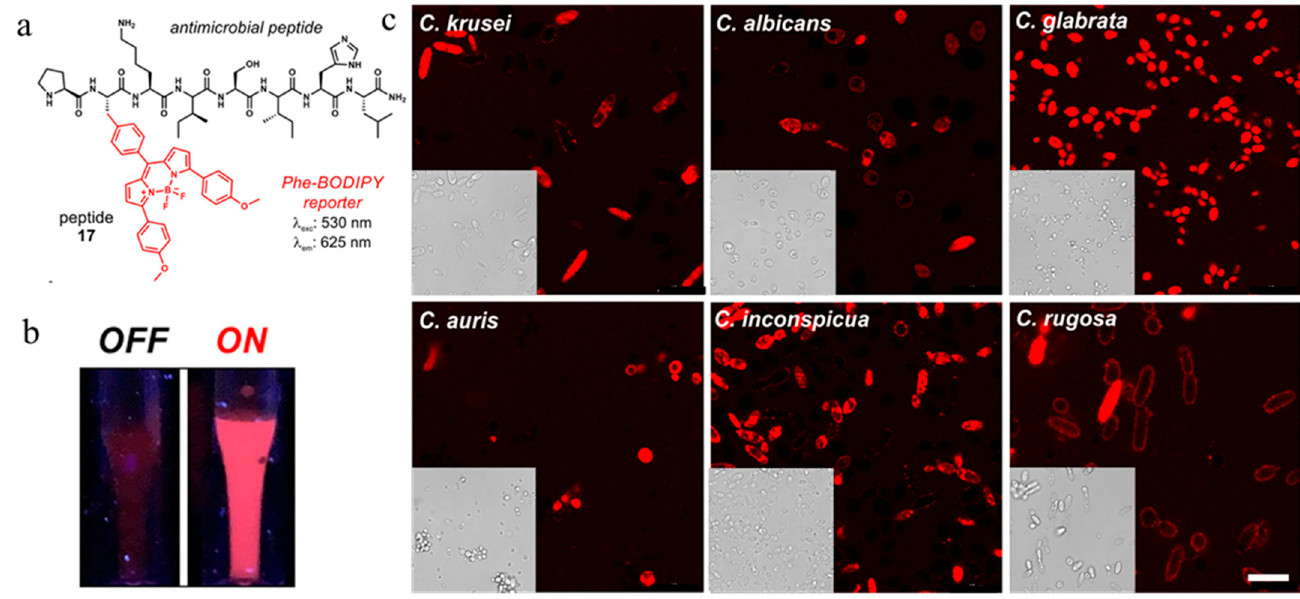
Figure 13. ( a ) Chemical structure of peptide 17 . ( b ) Photos of solutions of probe 17 (30 µ M) under excitation with a 365 nm UV-lamp in PBS ( left ) and liposomes ( right ). ( c ) Fluorescence live-cell confocal microscopy of different Candida strains after 1 h incubation with peptide 17 (10 µ M) in PBS at 37 ◦ C without any washings. λ exc: 575 nm, λ em: 600–650 nm. Scale bar: 10 µ m. Reproduced with permission from Ref. [80]. Copyright 2022, Wiley-VCH GmbH.